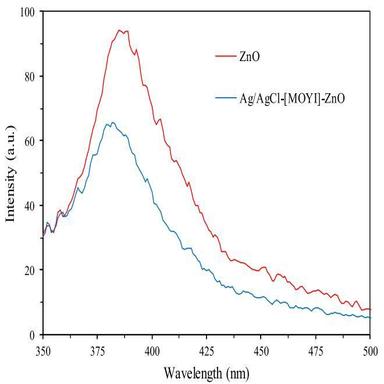
Photoluminescence spectra of ZnO and Ag/AgCl--ZnO.